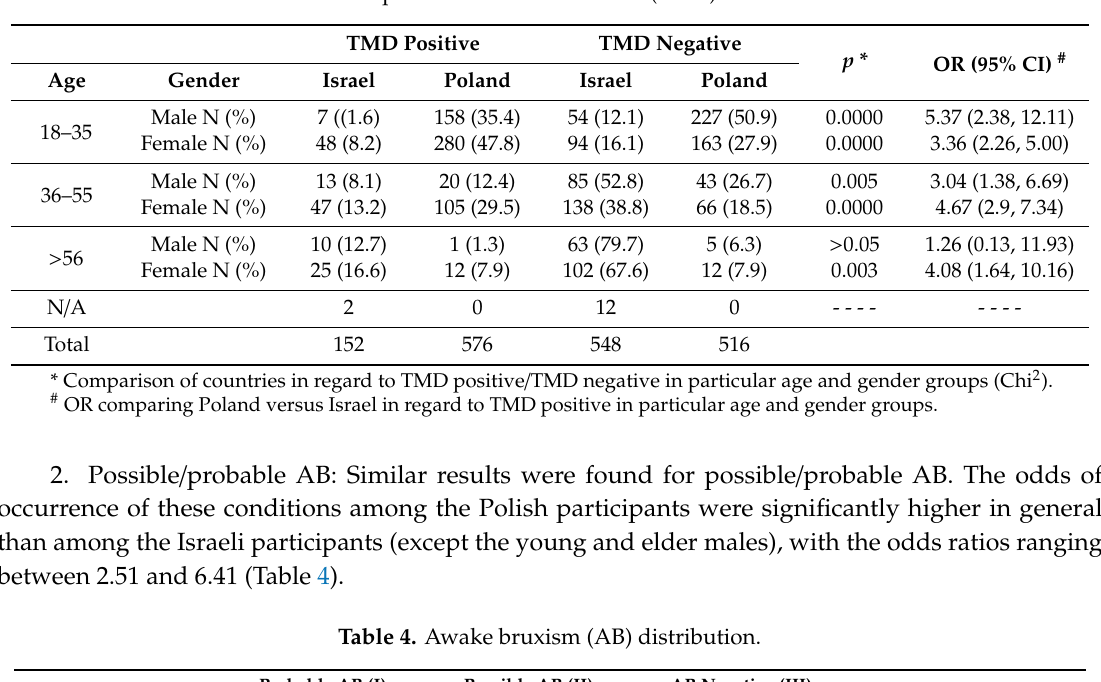
Table 3. Temporomandibular disorders (TMD) distribution.